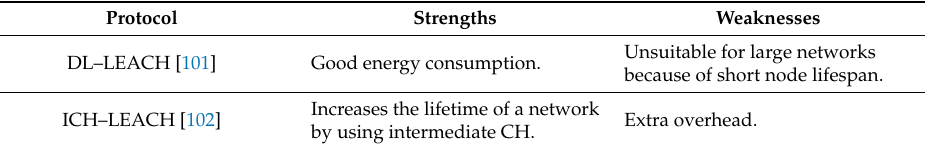
Table 9. Summary of distance-based cluster formation